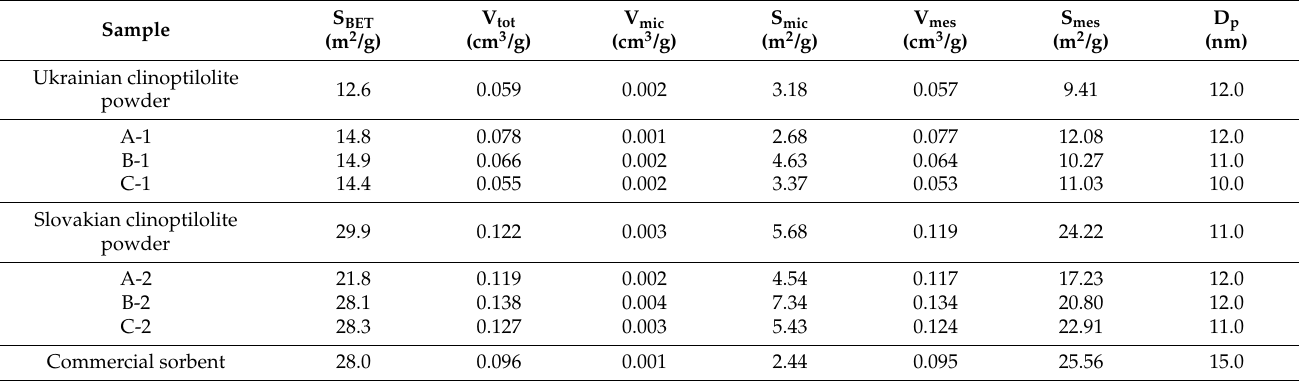
Table 4. The textural parameters for clinoptilolite powders and their consolidated forms using various binders.